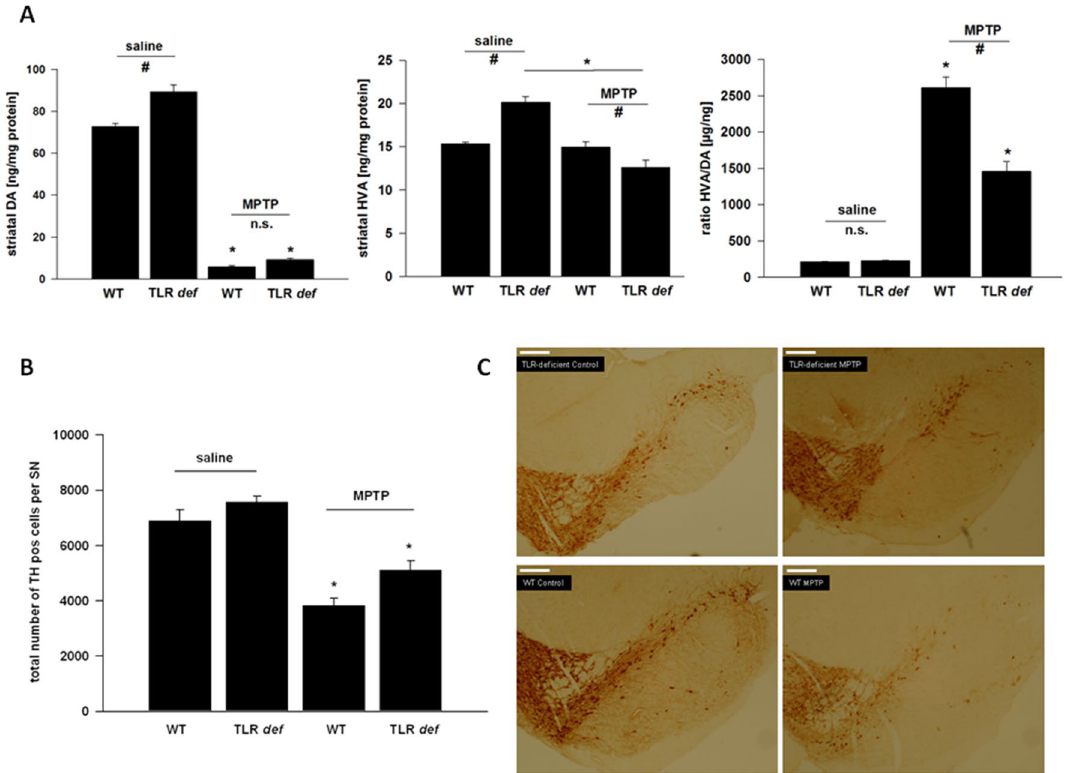
Figure 1. ( A ): HPLC measurement of striatal dopamine (DA) and homovanillic acid (HVA) levels, as well as calculation of the HVA/DA-ratio after MPTP-intoxication of TLR4- deficient (TLR def) and WT mice in comparison to saline treated mice. Values are expressed as mean ± SEM (*p < 0.05 comparing MPTP treated group with its saline control, # p < 0.05 comparing MPTP-treated groups of WT and TLR4-deficient mice. ( B ): TH-positive cell number in SN after MPTP treatment. WT = WT mice, TLR deficient = TLR4 deficient mice. Values are expressed as mean ± SEM (*p < 0.05 comparing MPTP treated group with its saline control). ( C ): Representative photographs of the SN of each treatment group is shown. TH-staining of free-floating cryomicrotome-cut sections at day 7. TLR4-deficient = TLR4-deficient mice, WT = wild-type mice. Control = saline treated mice, MPTP = MPTP-treated mice, Scale bars = 200